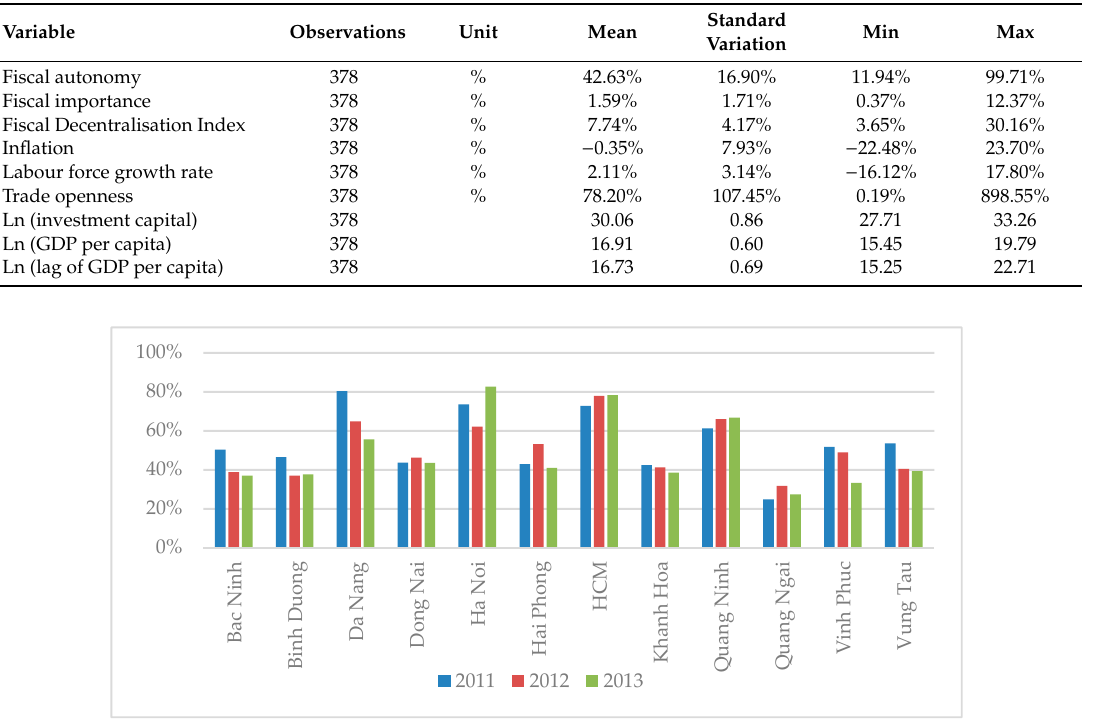
Figure 1. Fiscal autonomy ratio of selected provinces in Vietnam over the 2011–2013 period.